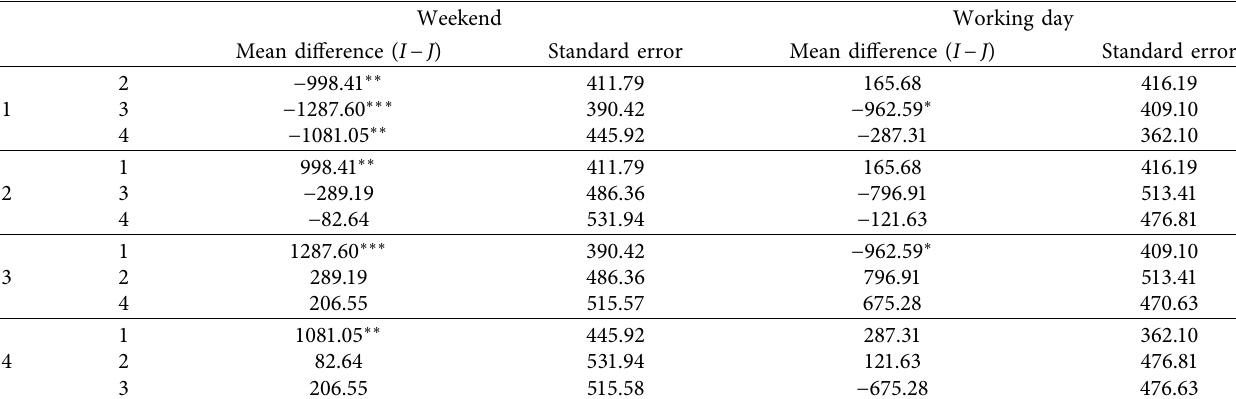
Table 3: ANOVA test of total travel